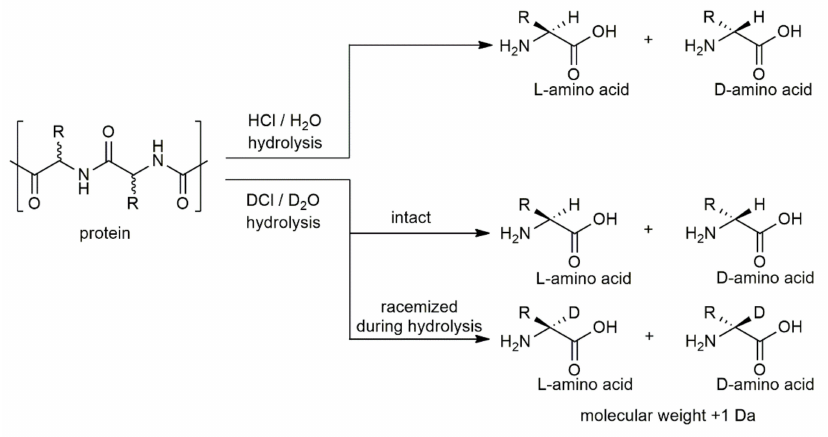
Figure 3. Amino acid racemization during protein hydrolysis under HCl/H 2 O and DCl/D 2 O conditions.